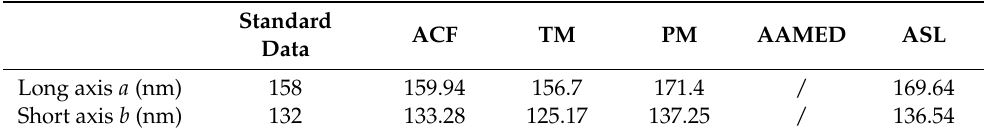
Table 3. Standard data and the results of the compared methods on dataset 3.